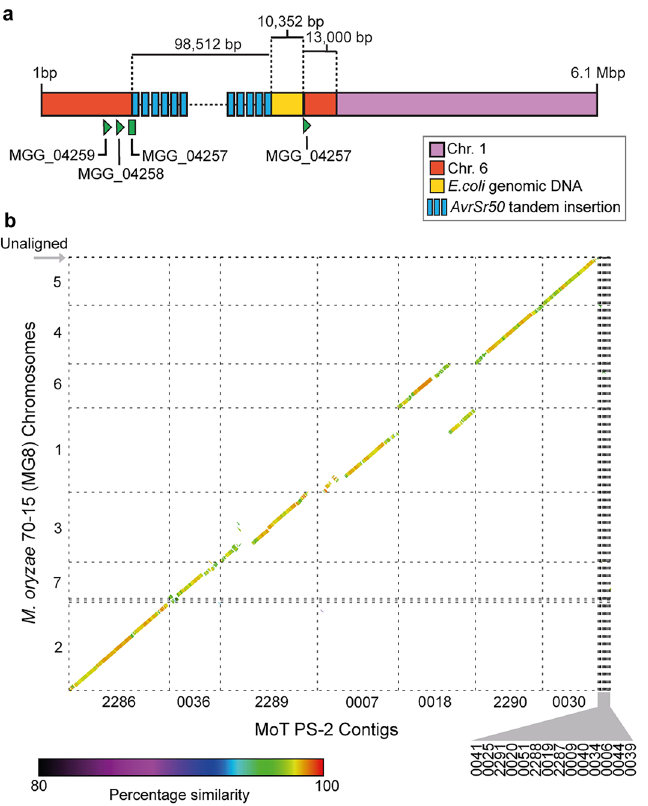
Figure 3. A single tandem insertion of the AvrSr50 transgene occurred in the MoT PS-2 transformant, near a region of known structural variation. ( a ) Schematic representation of the PWT3p::PWT3SP::AvrSr50 transgene integration site in the MoT PS-2 transformant. Following sequencing and assembly of the PS-2 genome, BLAST searches of the resulting contigs were used to identify regions of similarity with the M. oryzae rice blast reference genome (70–15), AvrSr50 construct and Escherichia coli genome. Green arrows indicate M. oryzae genes in the integration site that encode proteins with signal peptides in their N-terminus. Chr, chromosome. ( b ) Structural variation was evident between contig 0018 from the PS-2 genome assembly and chromosomes 1 and 6 of the MG8 M. oryzae rice blast reference genome of strain 70–15 as previously reported for MoT isolate B71 29 (Supplementary Figure. S8). Syntenic dot plot comparison between MoT PS-2 and M. oryzae 70–15 genomes shows genome order, with points coloured by sequence similarity. Alignments between the assemblies were performed using Nucmer and those with at least a 10 Kb match and 80% identity are